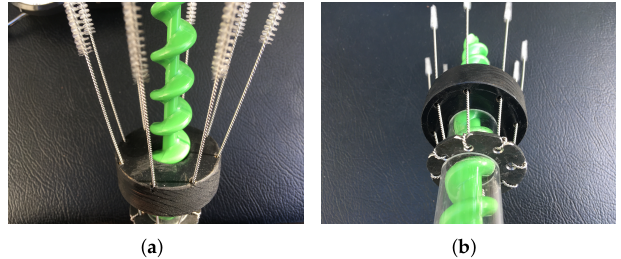
Figure 13. Wire Root Array: ( a ) Wire roots extend symmetrically around the anchor spike; ( b ) The wire root ring provides the attachment point for the wire roots and allows the array to slide